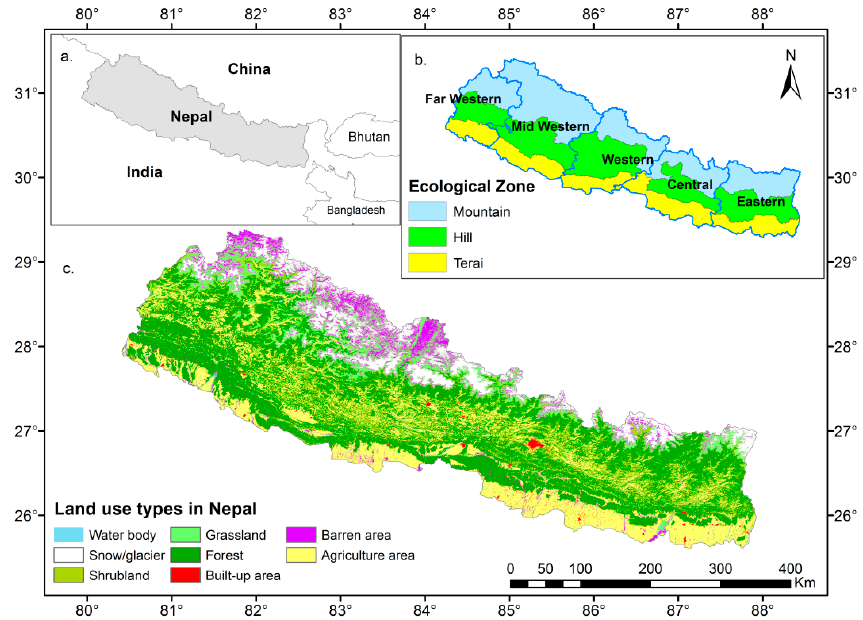
Figure 1. Study area: ( a ) Location map; ( b ) Ecological zone and administrative boundary of the study area; ( c ) land use types in Nepal.